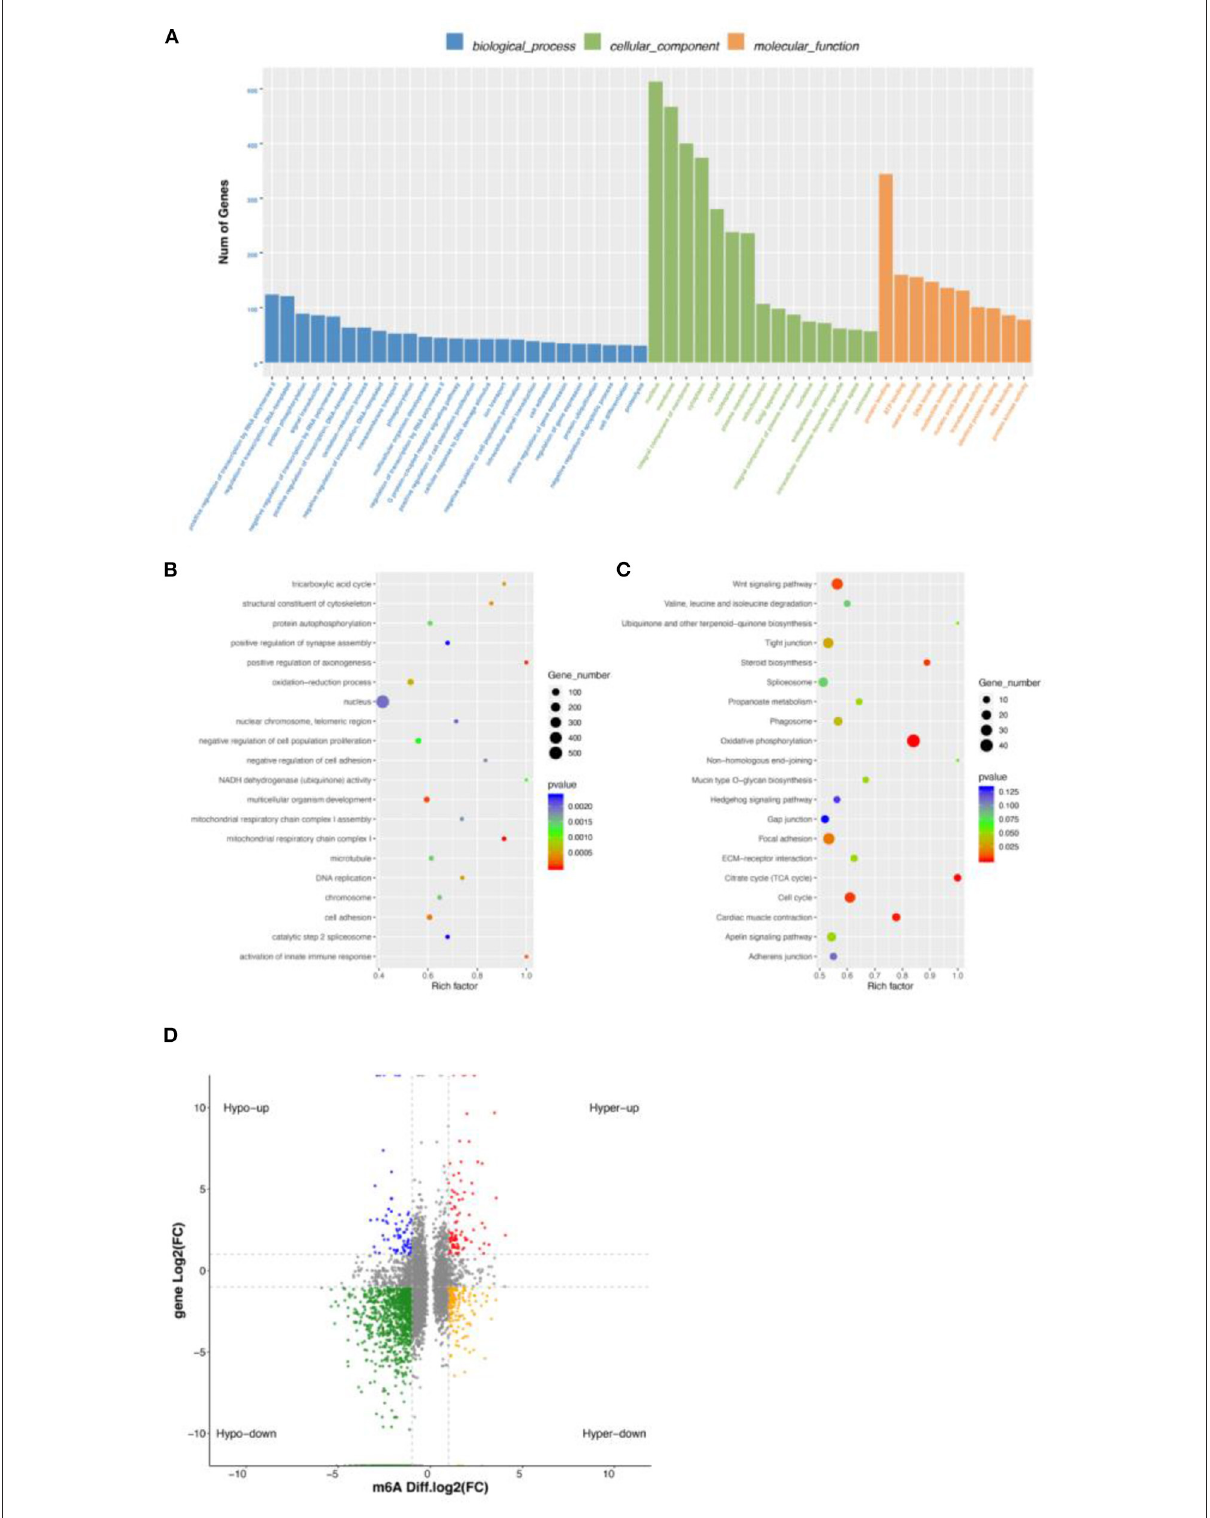
FIGURE4 Conjoint analysis of DEGs and DMGs. (A) GO enrichment barplot of DEMGs. (B) GO enrichment scatterplot of DMGs. (C) KEGG enrichment scatterplot of DEMGs. (D) Regulatory relationship between m6A and differential